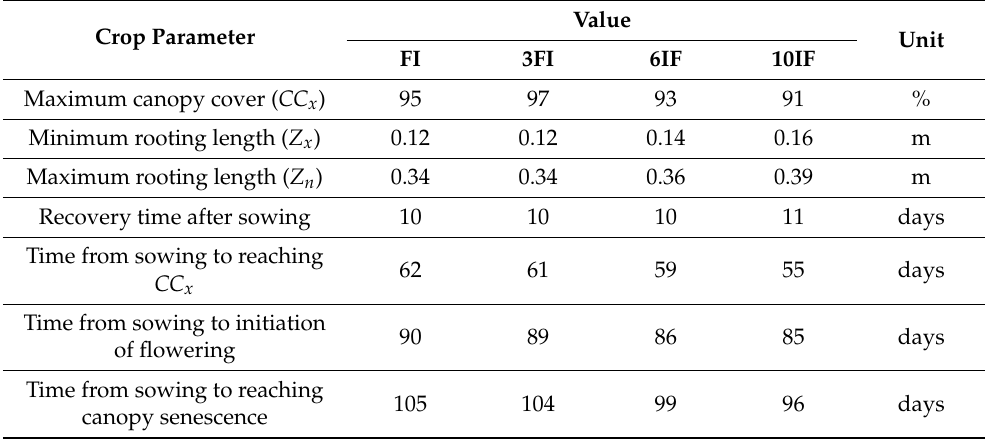
Table 2. Calibrated rice parameters used in the AquaCrop